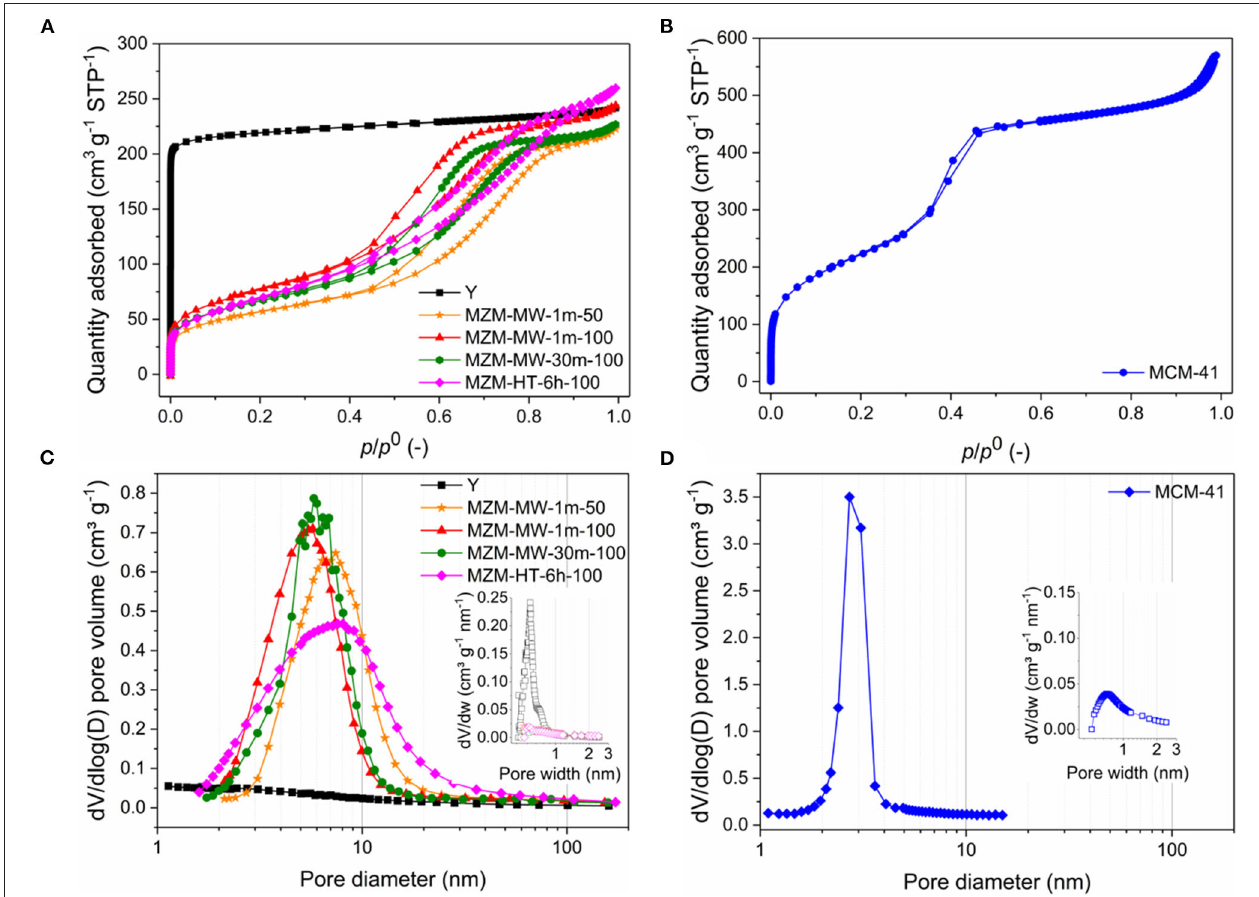
FIGURE 1 | N 2 adsorption-desorption isotherms of (A) MZMs (using Y zeolite as the reference) (B) MCM-41 and PSDs by the Barrett-Joyner-Halenda (BJH) method for (C) MZMs (using Y zeolite as the reference) and (D) MCM-41 [insets: the relevant micropore PSDs by the Horváth-Kawazoe (H-K)